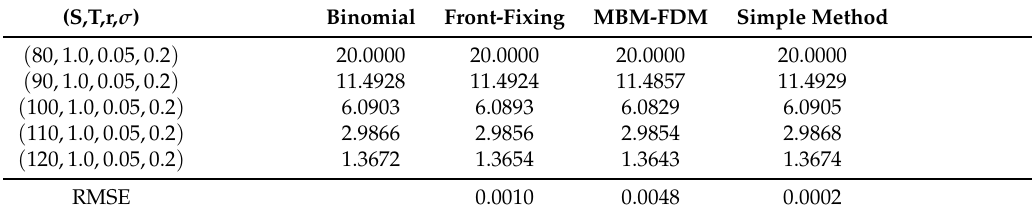
Table 2. Comparison of value of American put options calculated by various methods.